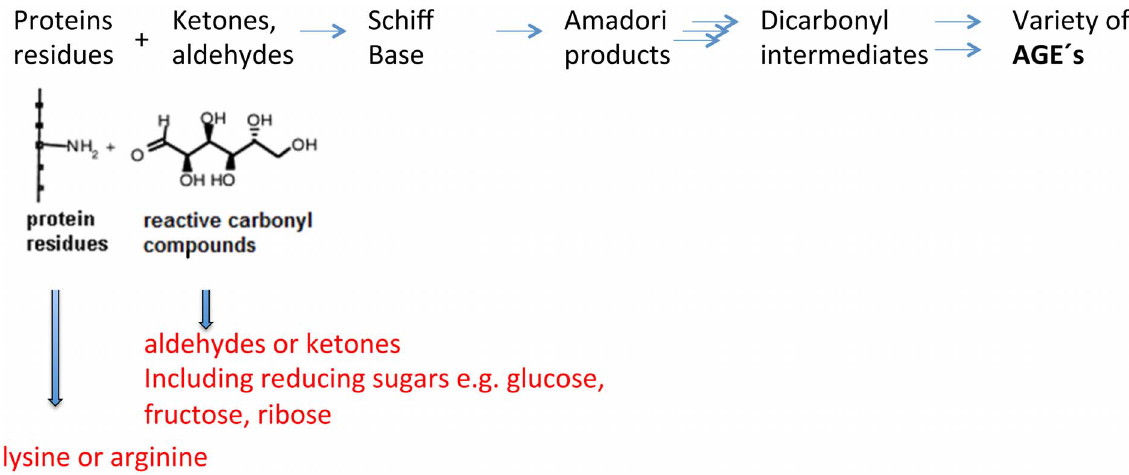
Figure 1. Formation of advanced glycation endproducts (AGE).